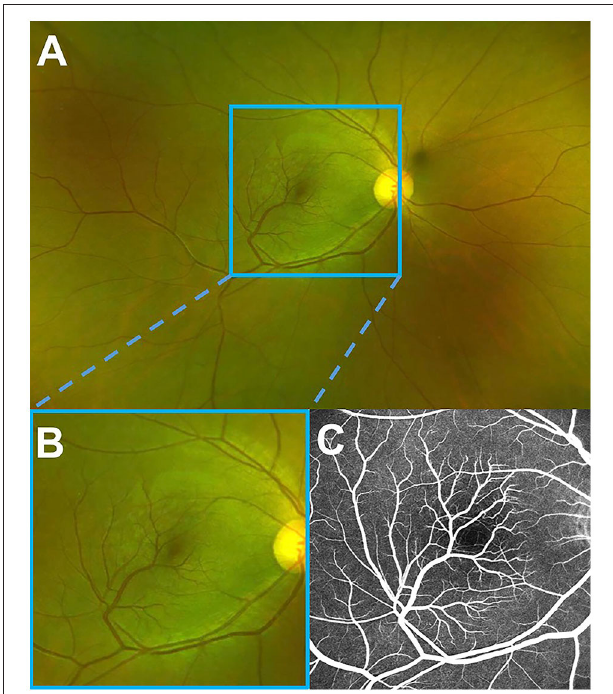
FIGURE 1 | A fundus photo and fluorescein angiography of the right eye. (A) Optos wide-field fundus image showing a branch of each artery and vein of the inferior retinal arcade, extending into macula with a sharp angle. (B) Magnified image demonstrating a better view of the macula. (C) Late fluorescein angiography, revealing no leakage of these vessels, the formation of the fovea avascular zone by the terminal arterioles, and the fovea-spared routine of the